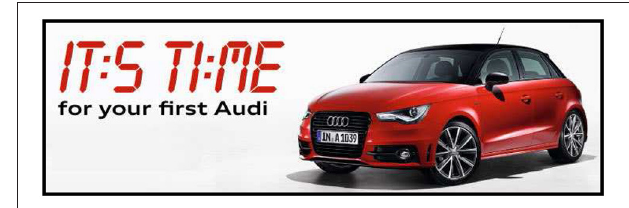
FIGURE 4 | It’s time for your first